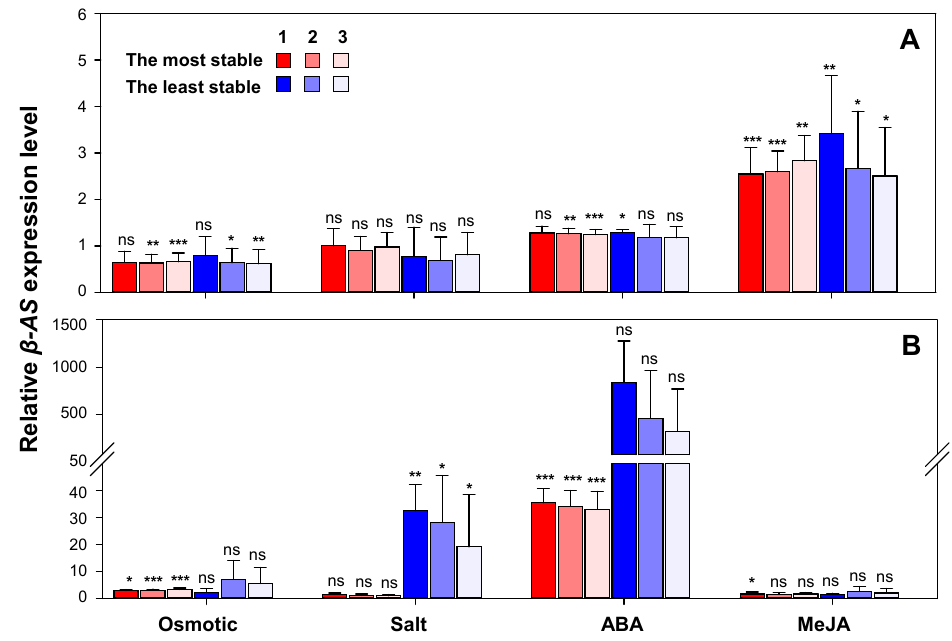
Figure 6. Validation of the recommended reference genes: expression profile of β -AS gene under different treatments relative to control in roots were investigated using the most/least suited, the top two most/least suited, and the top three most/least suited reference genes in G. uralensis ( A ) and G. inflata ( B ). Reference genes most suited or least suited for each species under different conditions are detailed in Table 1, Table S4, and Table S5. Bars represent the means ± standard deviation of biological replications. Results are presented as the fold change in relative expression compared to control using independent-samples T test method. * p < 0.05; ** p < 0.01; *** p < 0.001.